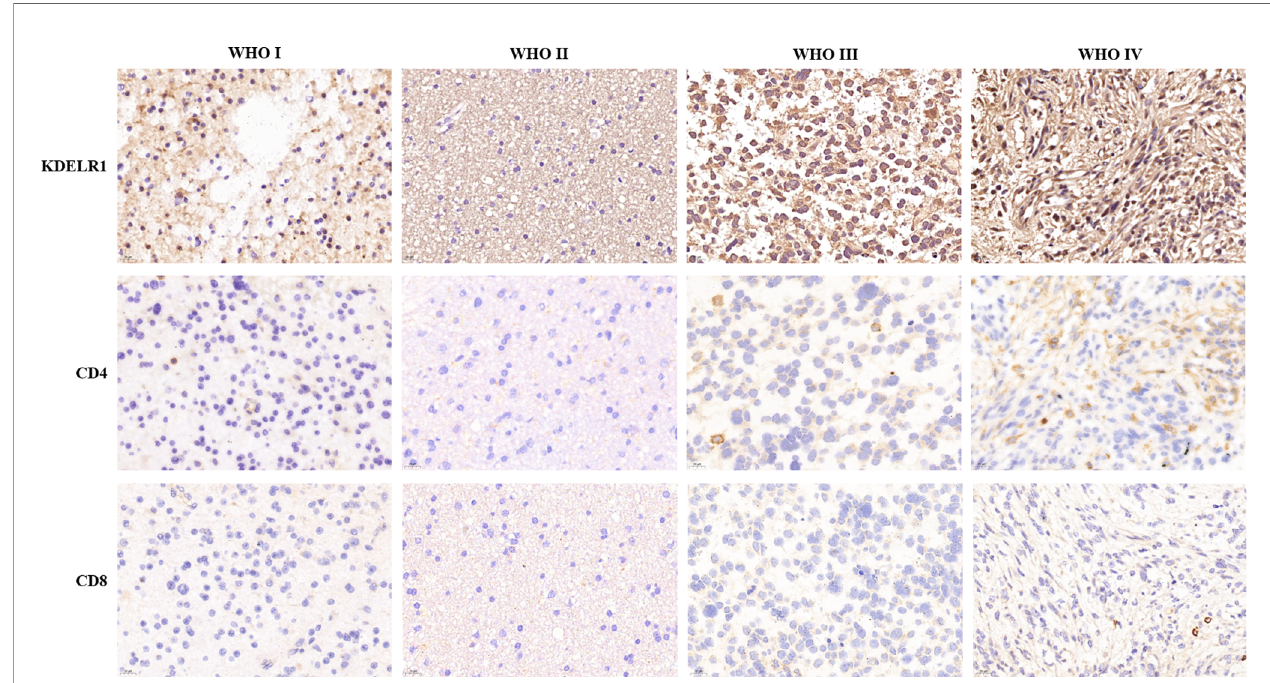
FIGURE 11 | Immunohistochemistry validation of KDELR1 expression and immune in fi ltration. Columns from left to right are WHO grade I, WHO grade II, WHO grade III, and WHO grade IV, and the rows from top to bottom are the IHC of KDELR1 (1:100, ×20 magni fi cation), CD4 (1:200, ×40 magni fi cation), and CD8 (1:200, ×40 magni fi